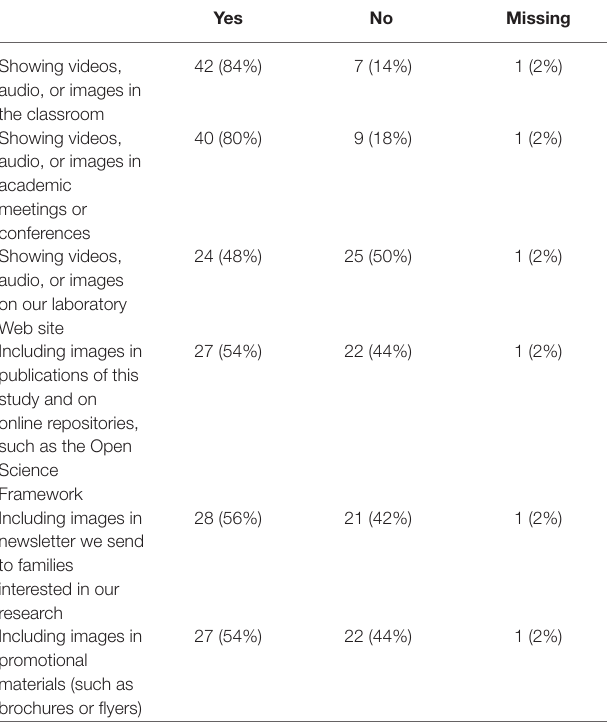
TABLE 4 | Parent media permission (Method